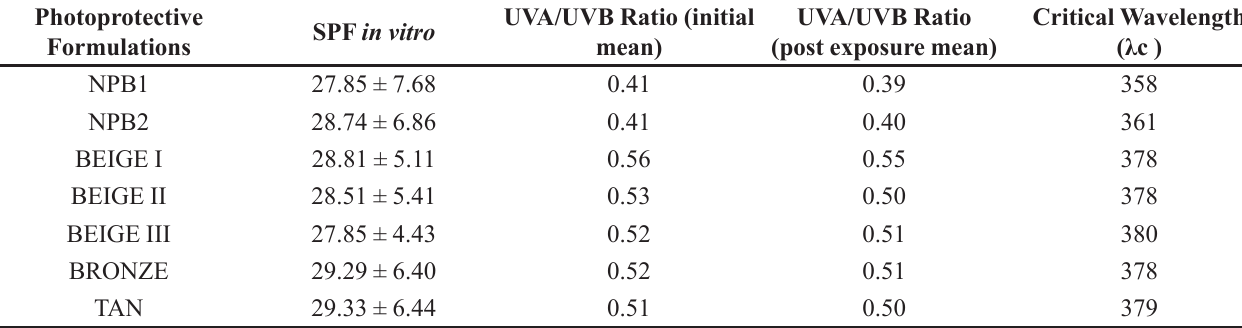
Photoprotective